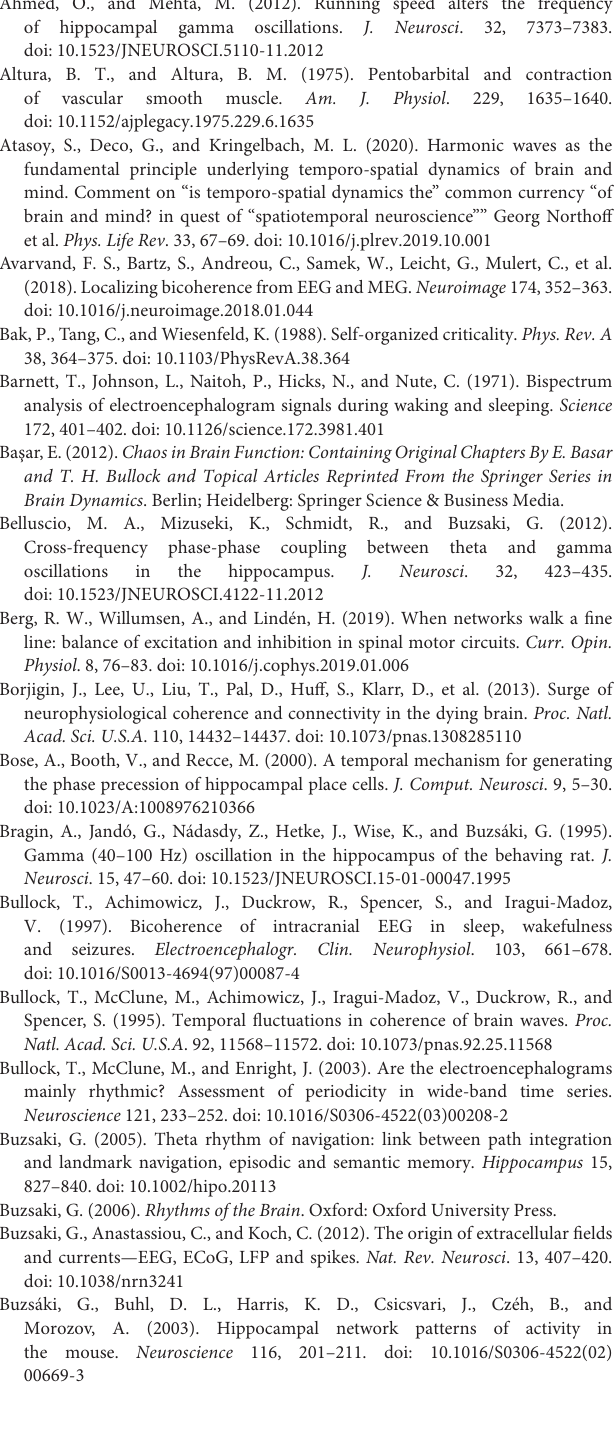
Supplementary Figure 8 | Similar with Figure 3 . Data from rat 730. Supplementary Figure 9 | Similar with Figure 3 without cross region coherence and bicoherence. Data from rat 829.